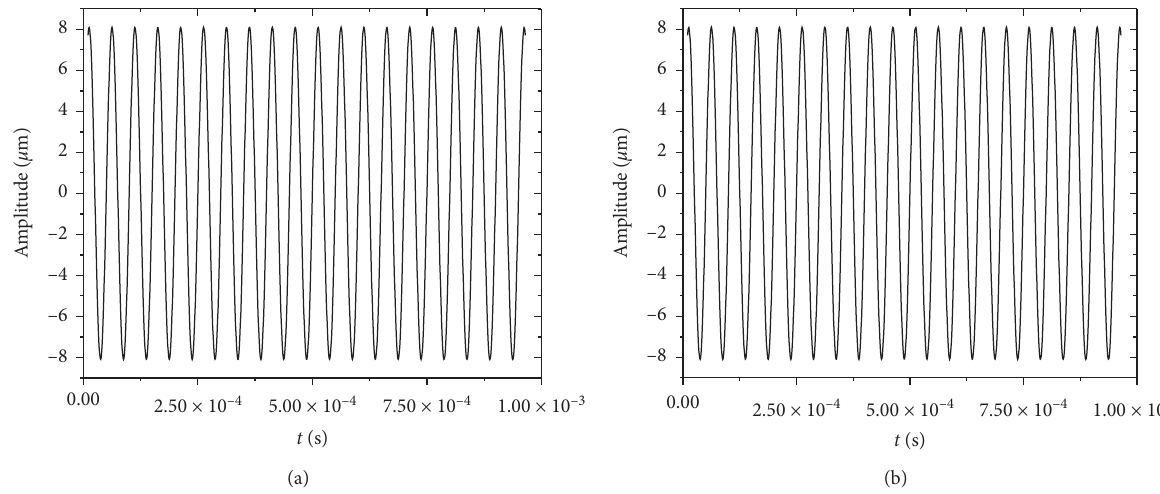
Figure 18: Fixed-frequency torsional amplitude. (a) X direction and (b) Y direction.